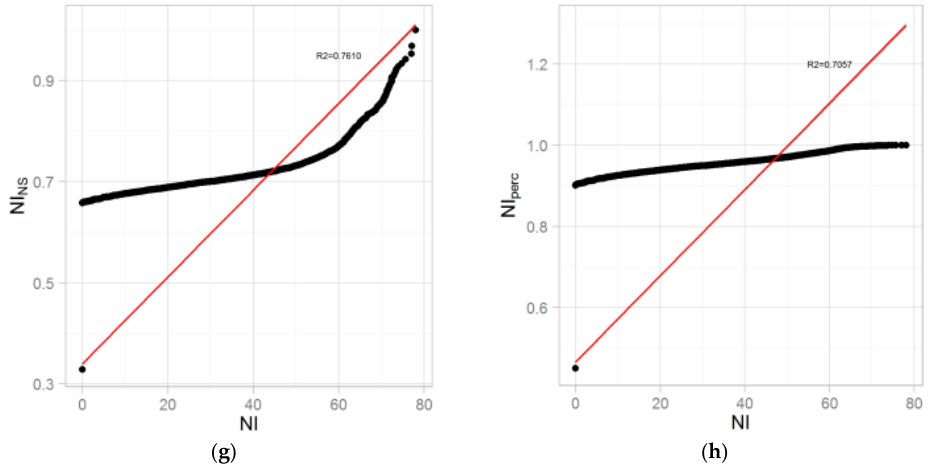
Figure A1. Correlation between subindicator before and after data transformation: ( a ) air and normal transformation; ( b ) air and percentile rank transformation; ( c ) soil and normal transformation; ( d ) soil and percentile rank transformation; ( e ) water and normal transformation; ( f ) water and percentile rank transformation; ( g ) noise and normal transformation; ( h ) noise and percentile rank transformation.